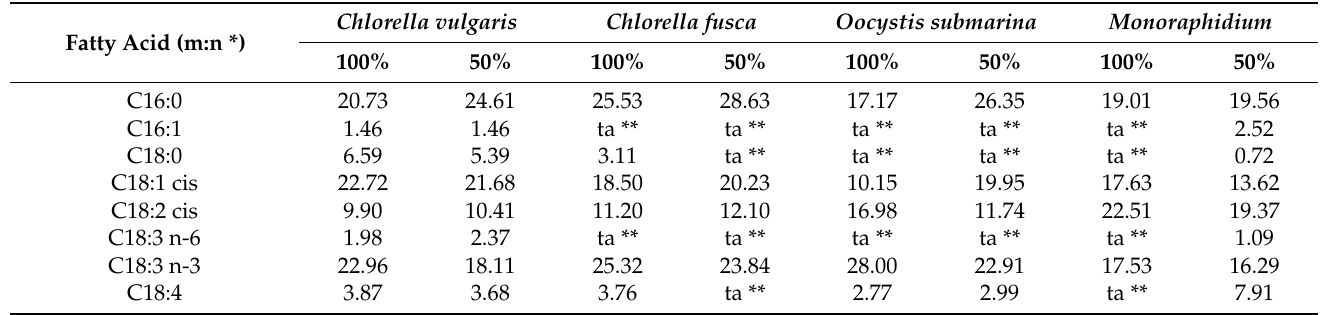
Table 1. Fatty acid profile of microalgae biomass.